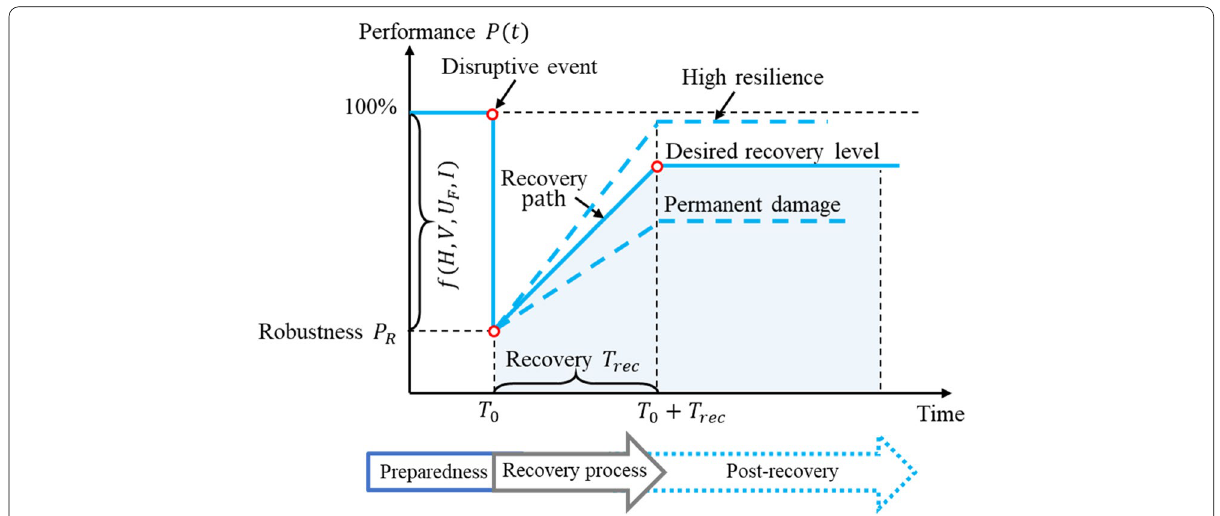
Fig. 4 Conceptual illustration of the resilience of a bridge subjected to a disruptive